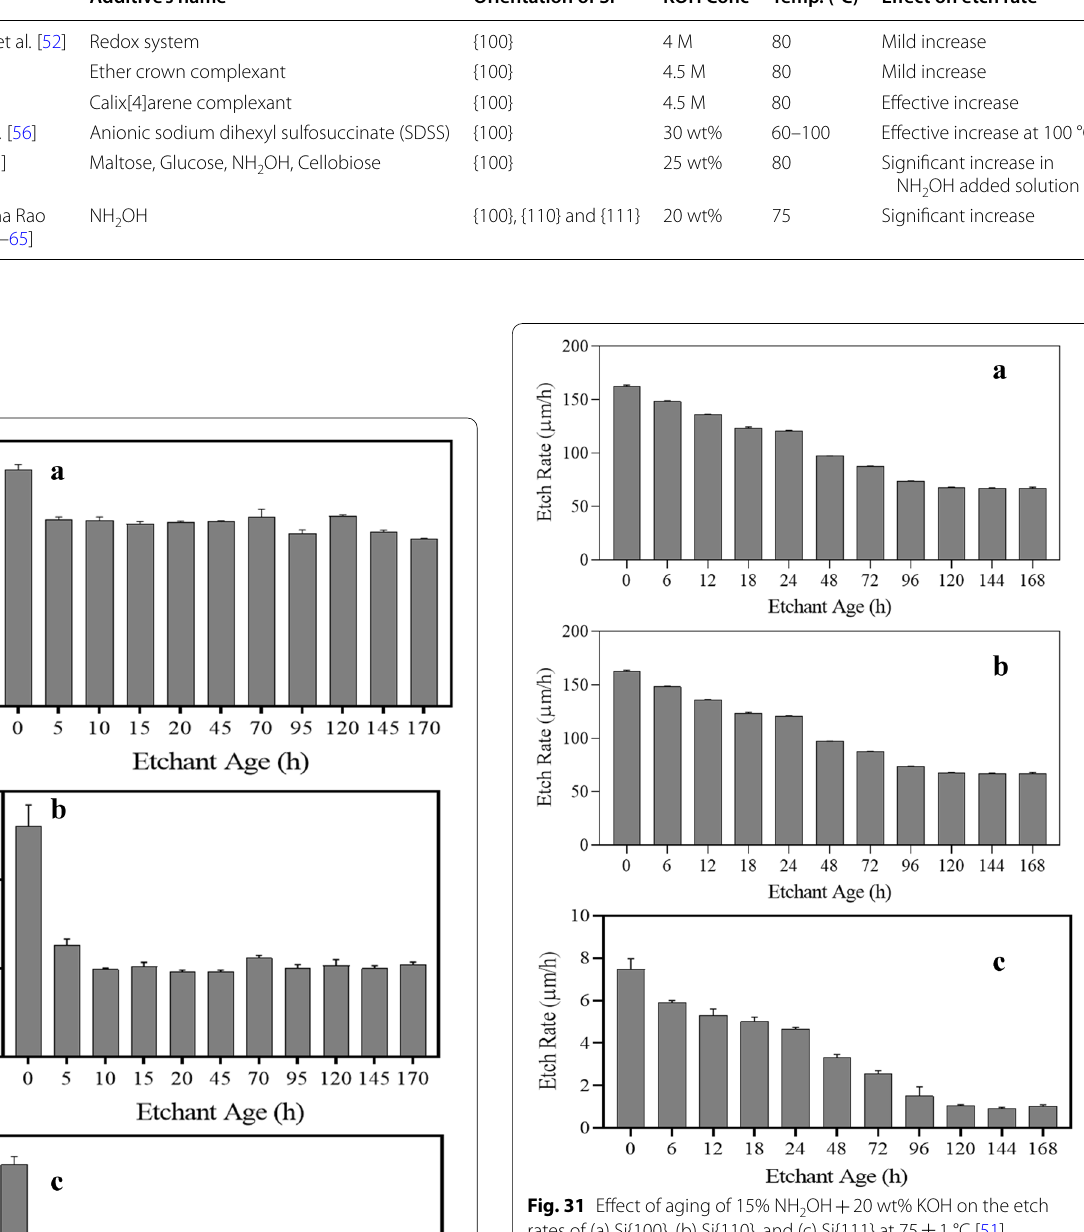
5 wt% TMAH on the etch + 1 °C [50] ±